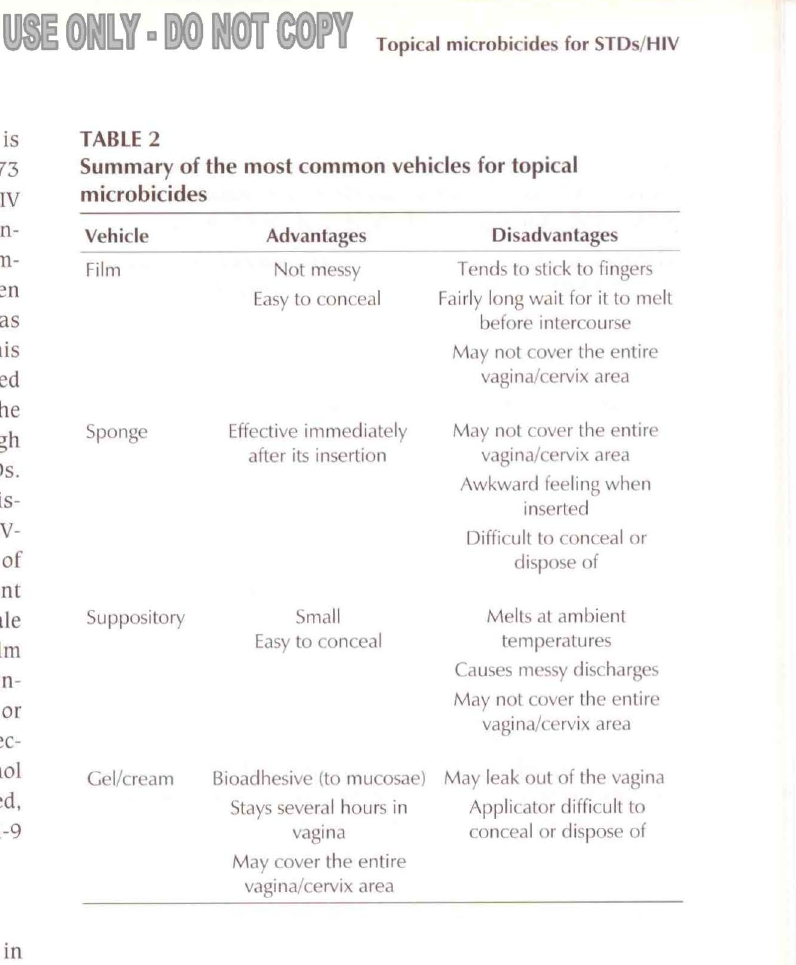
Summary of the most common vehicles for topical